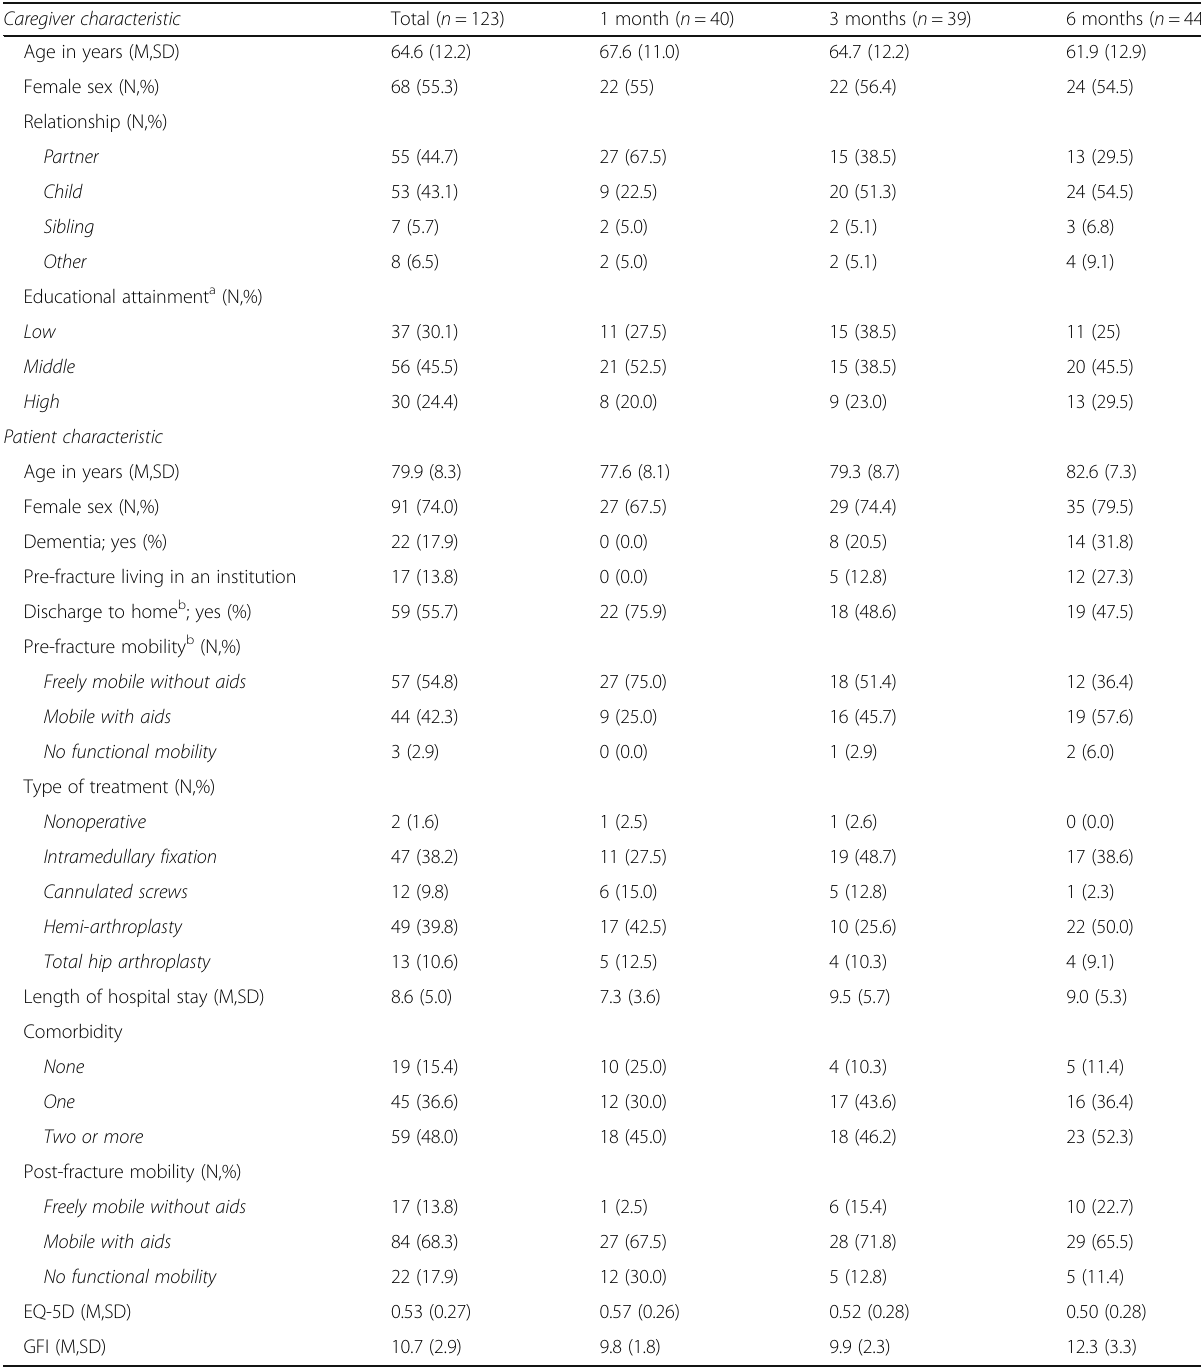
Table 1 Characteristics of informal caregivers and patients after a hip fracture Caregiver characteristic Total ( n =